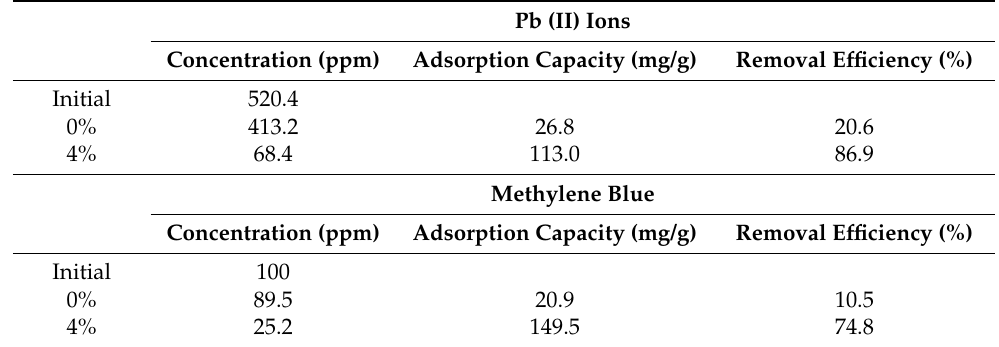
Table 4. Adsorption performance of the AS-0 and AS-4 powder for Pb (II) ion and methylene blue in aqueous